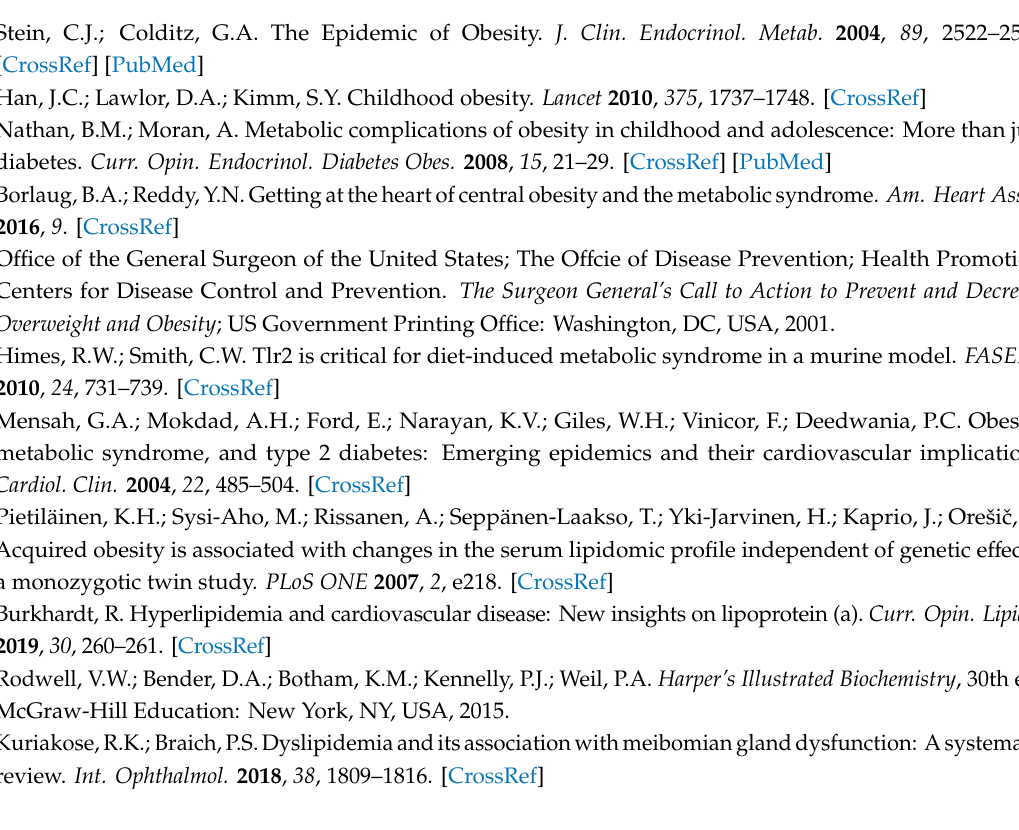
Figure A4. Correlation between mouse body weight and total plasma ( a ) TG-16:0, ( b ) TG-18:0, ( c ) TG-18:1, ( d ) TG-18:2 ( e ) TG-18:3 ( f ) TG- 120:4 and ( g ) TG-22:6. The grey-shaded regions represent the 95% confidence interval. Asterisks indicate a significance di ff erence compared to the matched ND